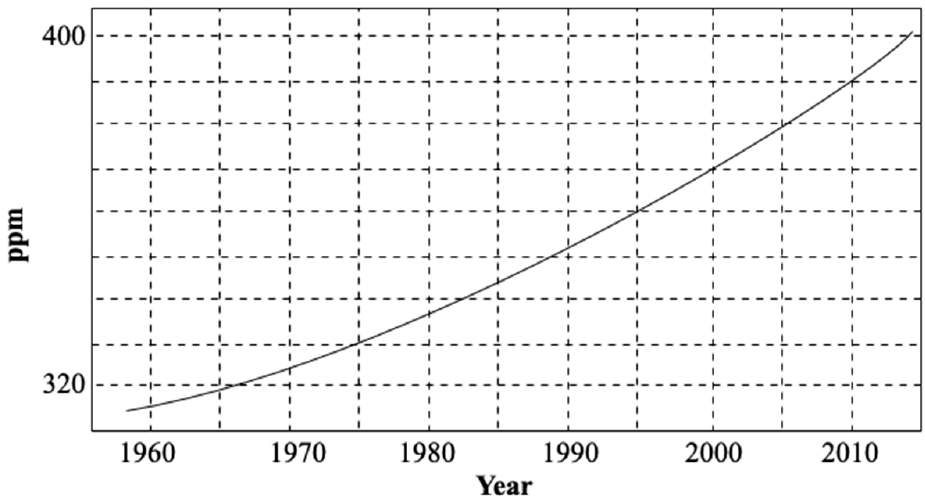
Figure 1. Carbon dioxide concentration (adapted from https://climate.nasa.gov/climate_resources/7/graphic-carbon-dioxide-hits-new-high/, accessed on 20 November 2021). When analyzing the current period, it appears that similar episodes continue to occur [17]. In other words, volcanic events continue to occur, with the emission of large amounts of greenhouse gases into the atmosphere and naturally caused forest fires, which sometimes reach epic proportions and are also responsible for the emission of gigan- tic amounts of CO 2 into the atmosphere. Then, as happened throughout the entire existence of the planet, natural processes, such as chemical carbonation processes, dissolution in ocean water, or plant photosynthesis, will return to balance the system, recapturing and storing this carbon